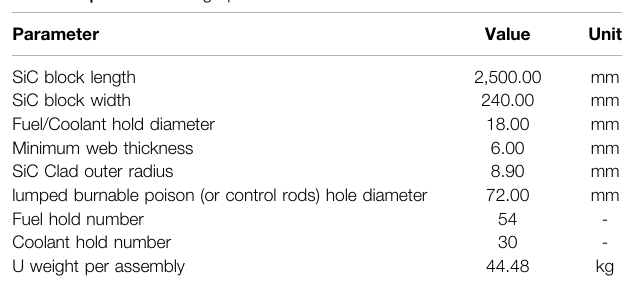
TABLE 3 | FCM fuel design